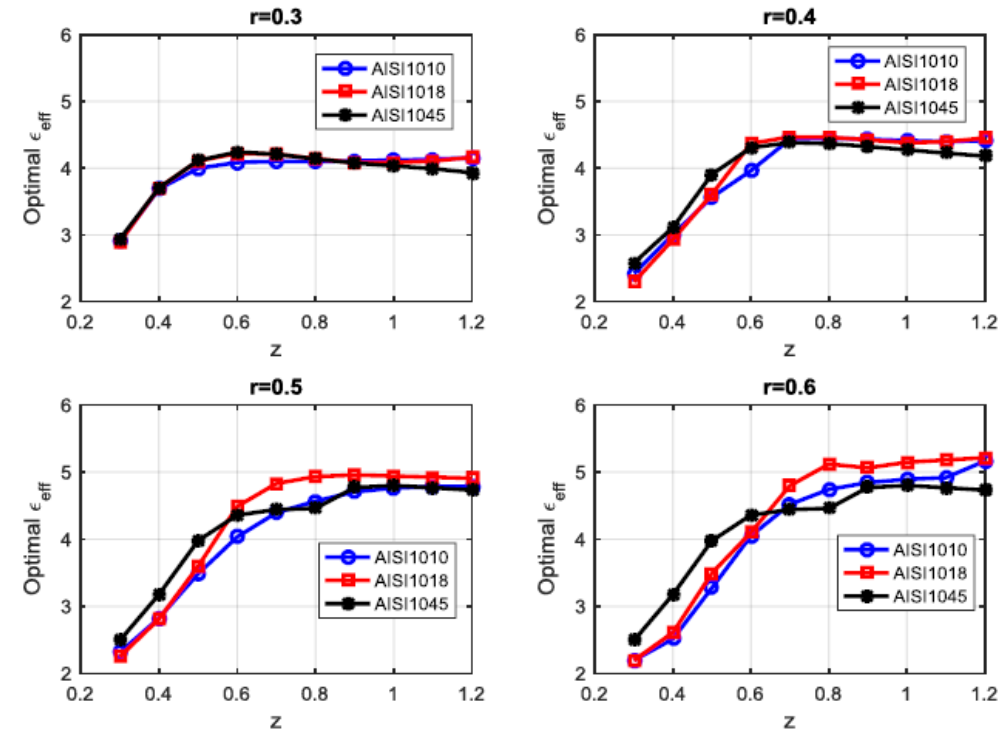
Figure 15. Comparison of optimal values of the effective strain of different steels.